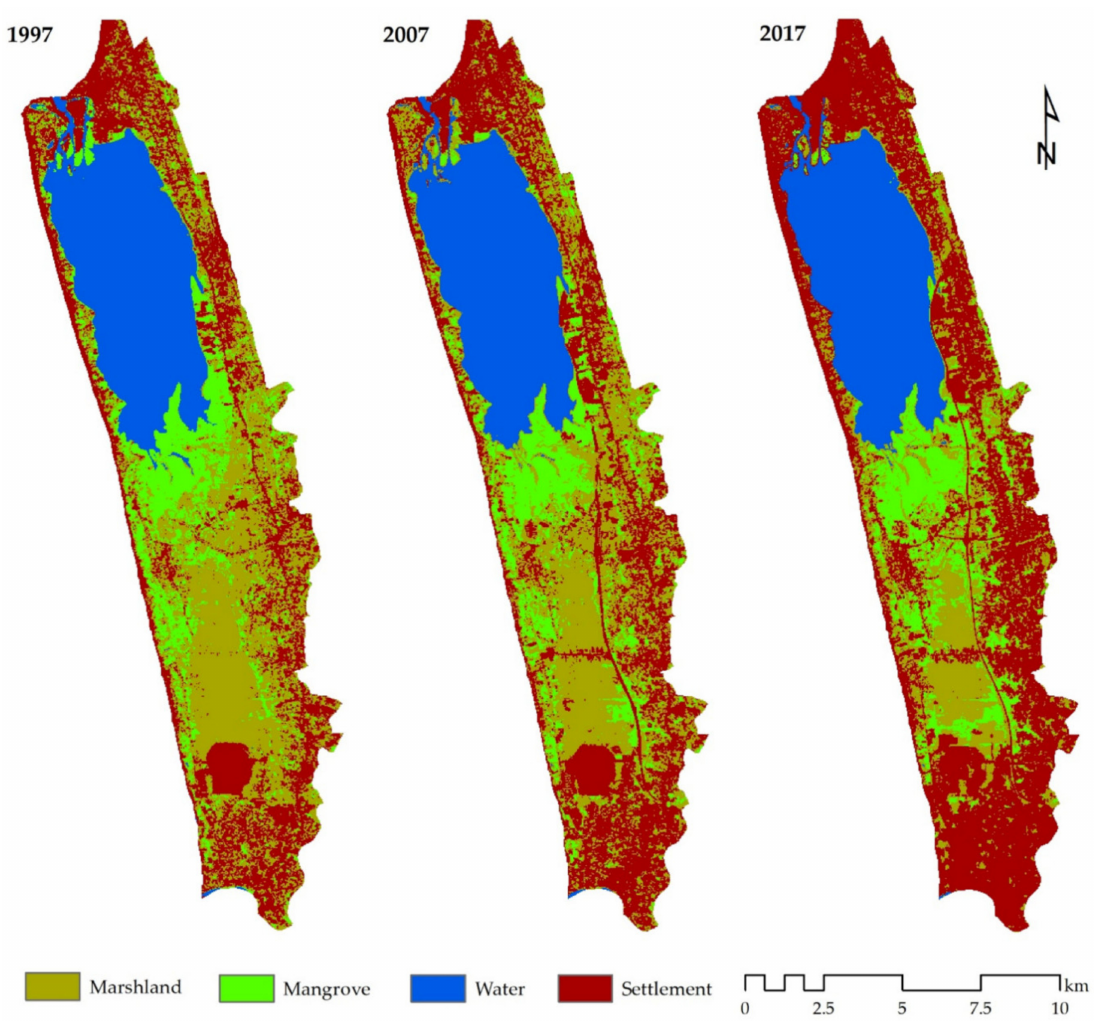
Figure 3. LUC maps of the MMNL in 1997, 2007, and 2017 derived from Landsat data (see Methods).